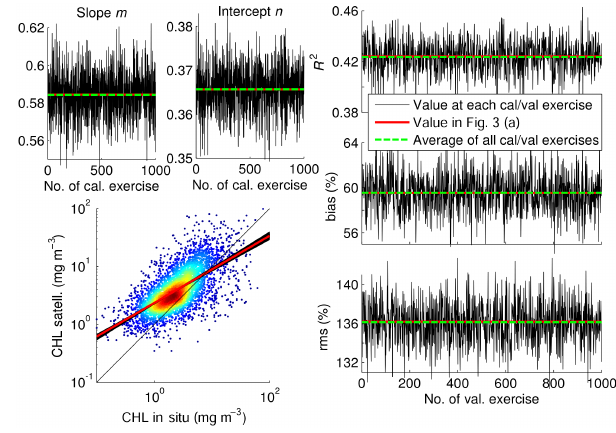
Figure 4. Upper left panels, in black: best linear fits (slope m and intercept n ) of 1000 randomly chosen calibration data sets ( N cal = 2246, x axis) of log 10 (CHL a in situ ) vs. log 10 (CHL a OC4v6 ) . Lower left panel: application of all 1000 ( m , n ) pairs to the OC4v6 vs. in situ scatter cloud. In red, slope and intercept for the whole data set, as shown in Fig. 3a. In green, aver- age of the 1000 calibration results. Right panels, in black: statistics when applying each m and n pair from the left side to the comple- mentary validation data sets ( N val = 2246, x axis). These are the coefficient of determination, bias (Eq. 1), and rms (Eq. 2). Same statistics found for the whole data set, as shown in Fig. 3a, are in red. The average of the 1000 validation results is in